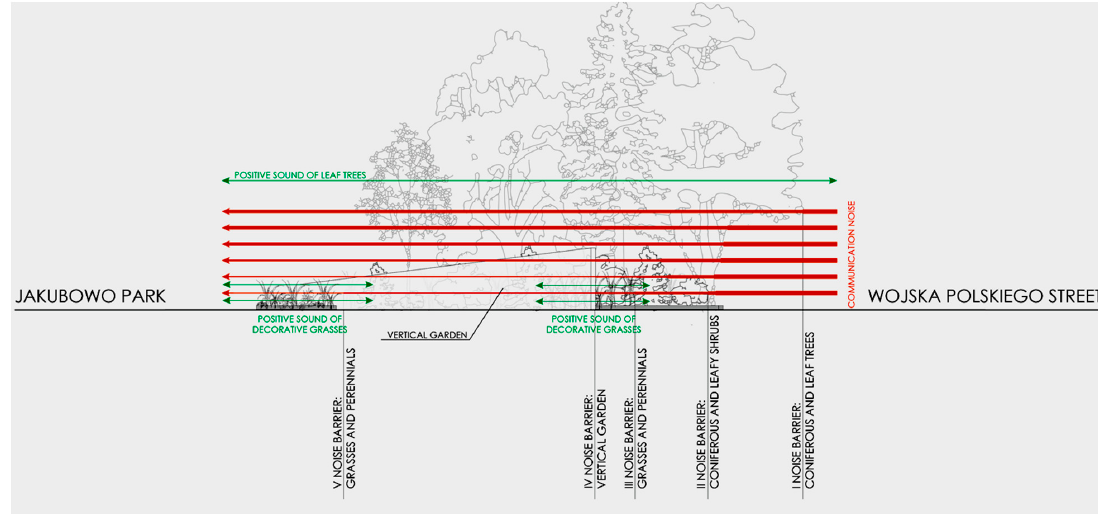
Figure 16. Model example for the Jakubowo park: a plant barrier solution in different zones depending on the distance from the main street, and introduction of positive sounds. Source: authors.